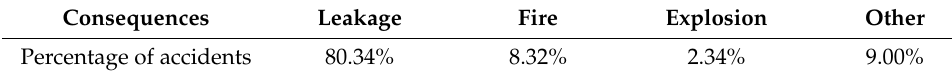
Table 4. The number and percentage of accidents by consequences.